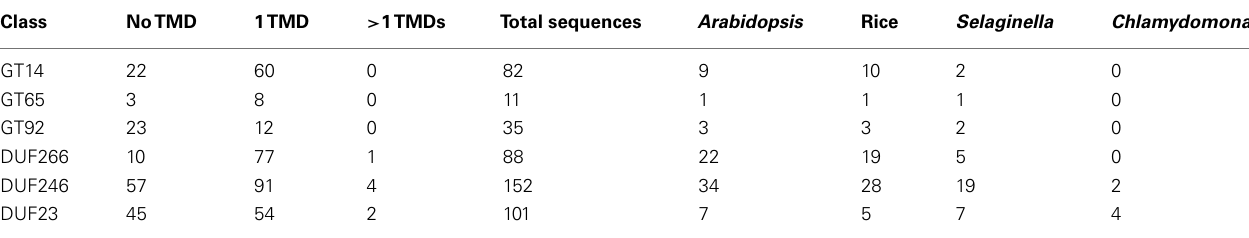
Table 1 | Summary of the three putative GT families and the GT families they are related